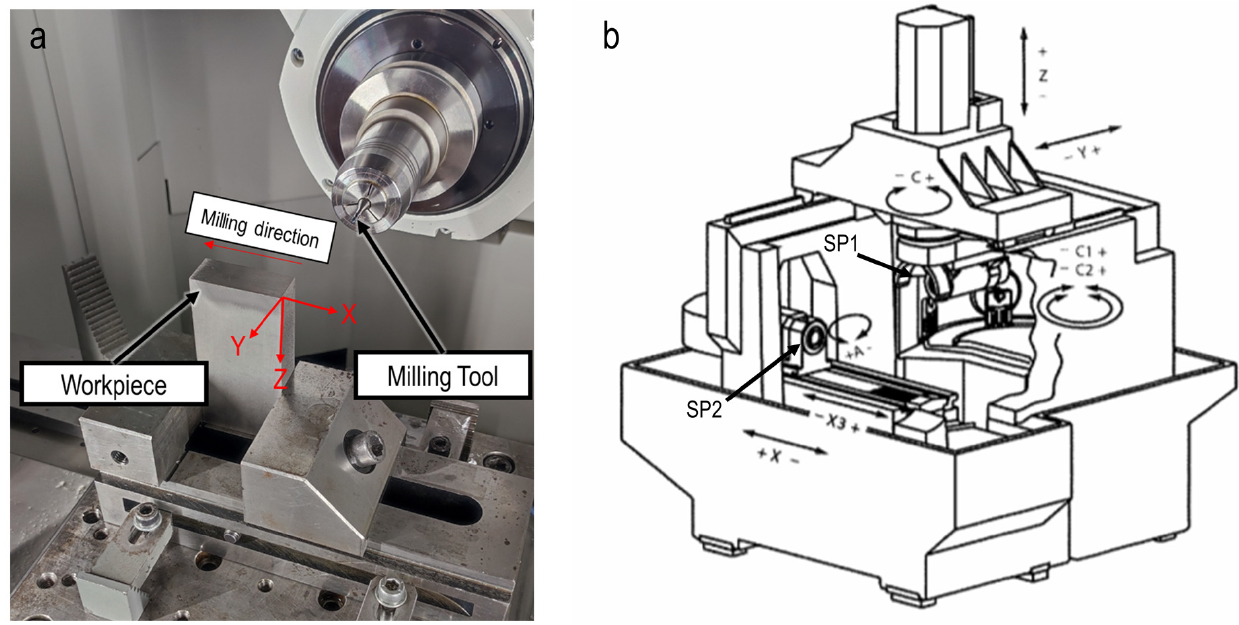
Figure 2. ( a ) Experimental setup. ( b ) Illustration of different axes.